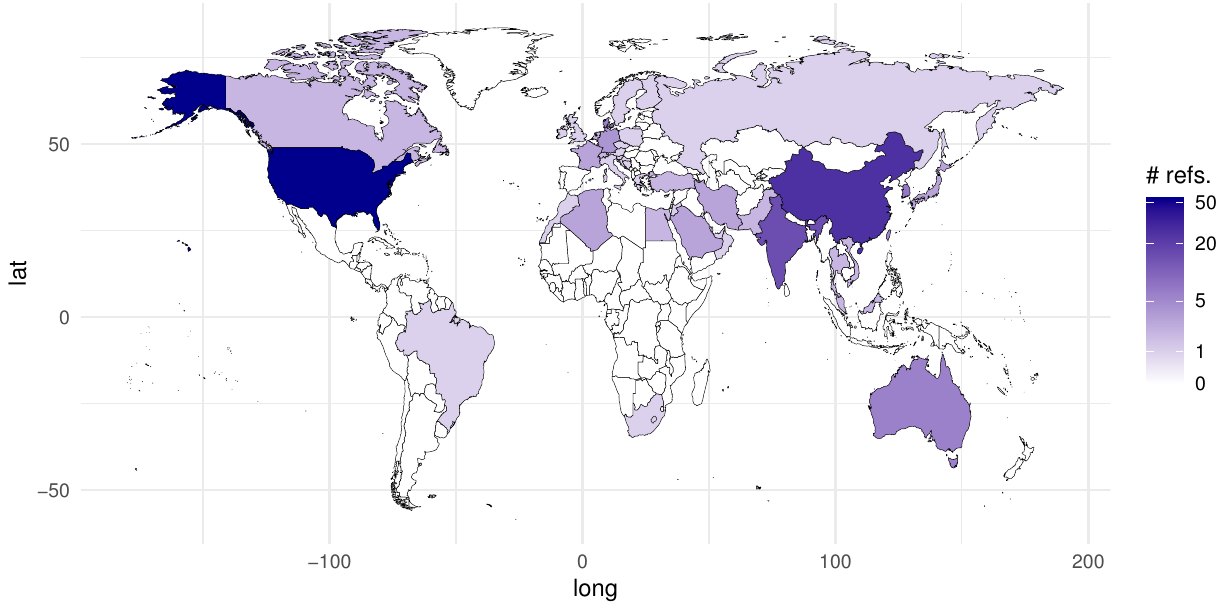
Figure 2. Rough categorization of the research field related to the smartization of DER inverter operation.